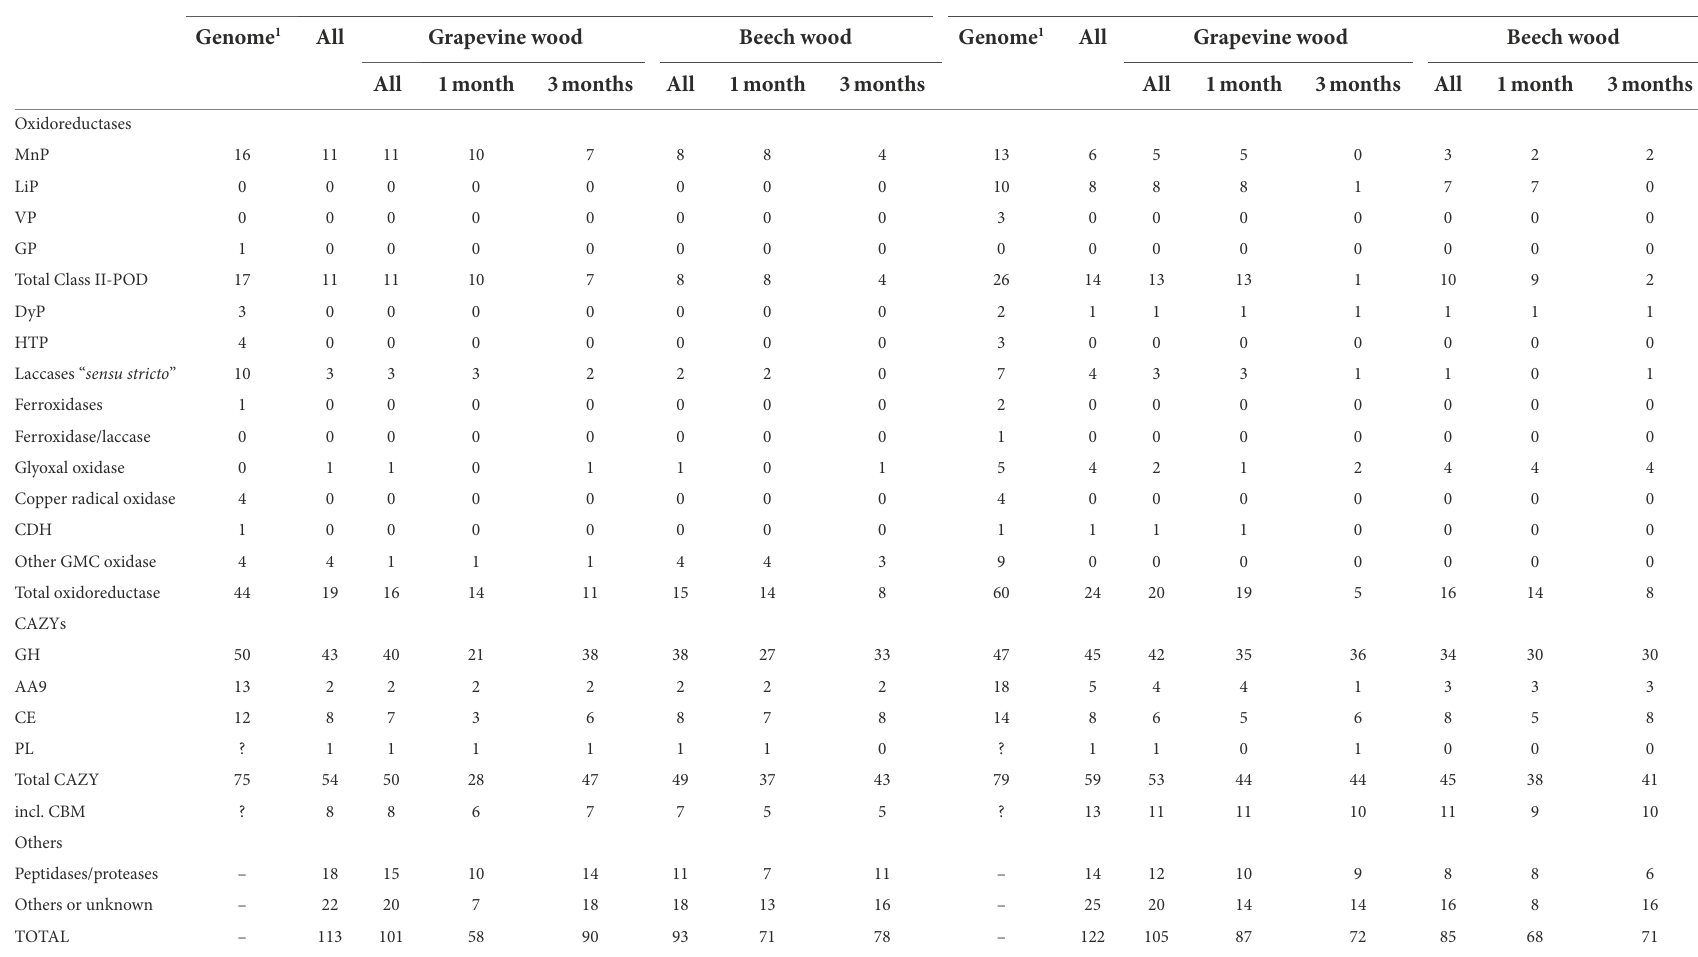
TABLE 1 Number of detected proteins functionally classified in Fmed and Tver secretomes on grapevine and beech wood sawdust in 1- and 3-months cultures. Protein